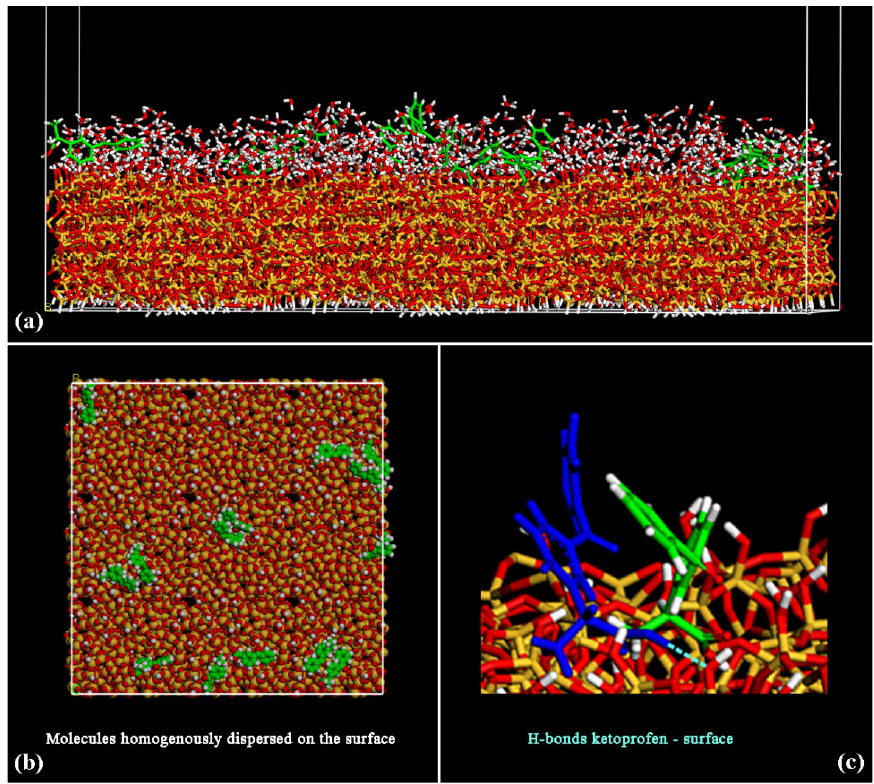
Figure 3. Optimized geometry after MD run of 14 ketoprofen drug molecules in racemic mixture adsorbed on hydrated amorphous SiO 2 surface, in particular, the side view is in panel ( a ) and the top view in panel ( b ) without water molecules for clarity. Color code: carbon atoms are in green, oxygens in red and hydrogen atoms in white. In panel ( c ) the atoms of ketoprofen molecule that form an H-bond with the SiO 2 surface are reported in blue.